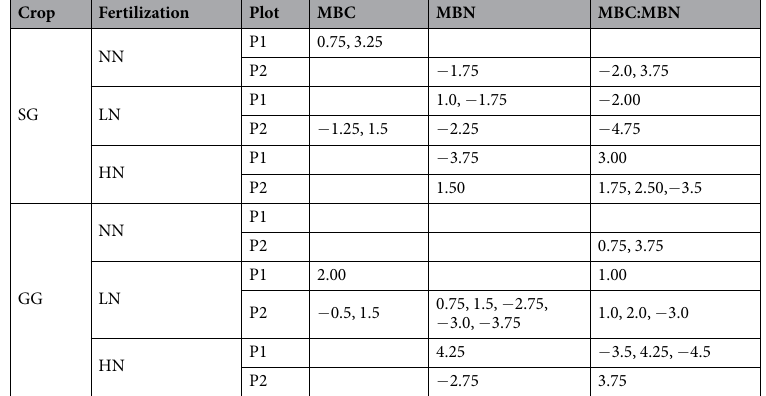
Table 4. Summary of significant distance for spatial dependence based on Moran’s I values for MBC, MBN and MBC:MBN in 12 plots in a three-year long fertilization experimental site at the Tennessee State University (TSU) Agricultural Research Center in Nashville, TN, USA. The unit of the distance for spatial dependence is meter. The abbreviations are referred to Table